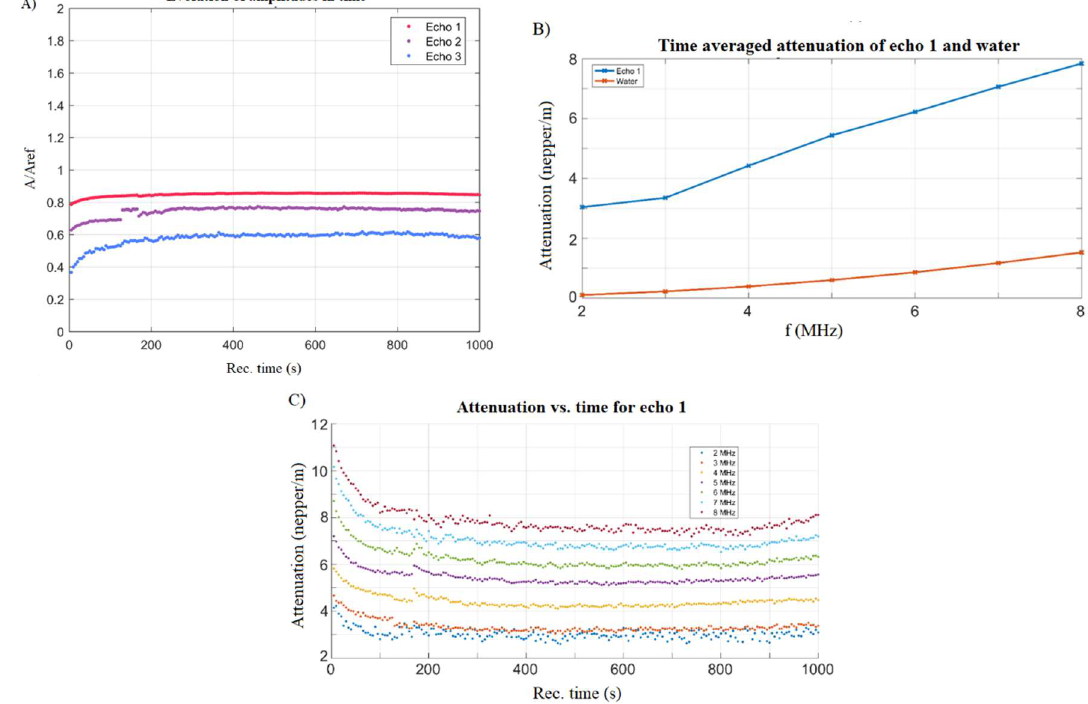
Figure 4. Evolution in time of the echoes amplitudes ( A ), spectral attenuation of echo 1 and reference fluid ( B ), and spectral attenuation vs. time for echo 1 ( C ).